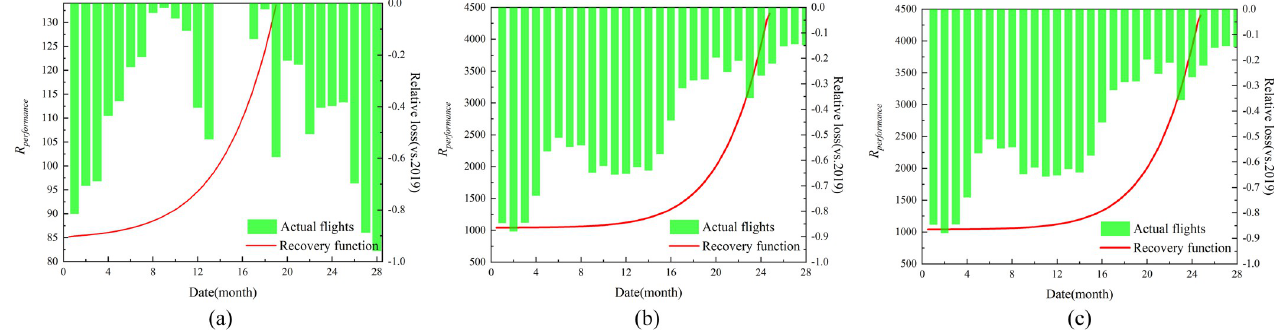
Fig 5. Recovery comparison of airport